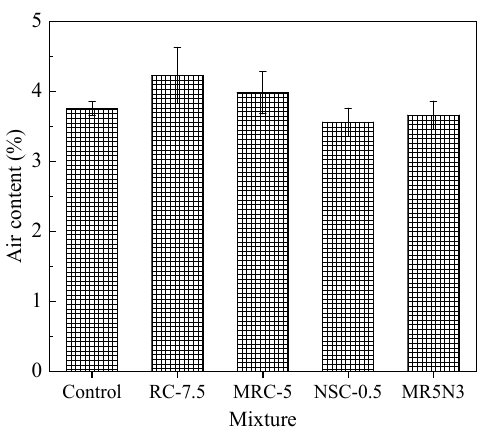
Figure 10. Air content of concrete.